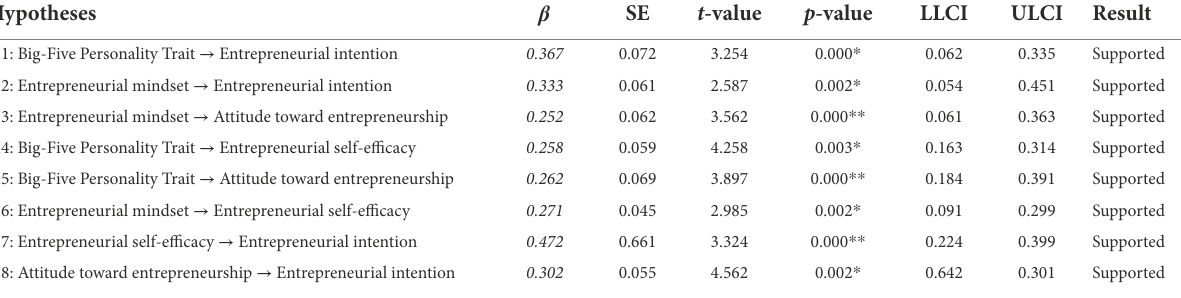
TABLE 5 PLS hypothesis testing.